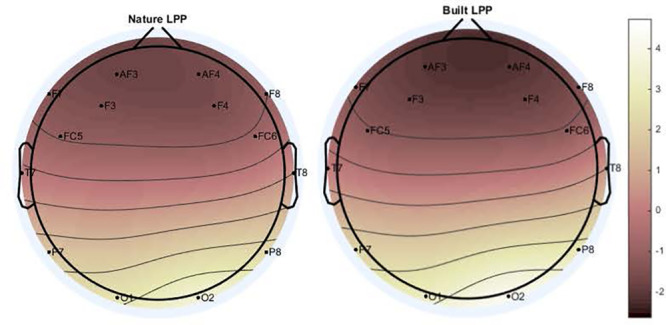
Main effect of Environment indicates natural stimuli elicit lesser LPP mean amplitude than built stimuli across all channels [F(1.97,116.25) = 50.845; p < 0.001; ηp2 = 0.463]. Differences in frontal and posterior channel polarity were resolved by dividing subsequent analyses into frontal channels only (AF3, F3, F7, FC5, FC6, F4, F8, and AF4) and posterior channels only (T7, P7, O1, O2, P8, and T8).